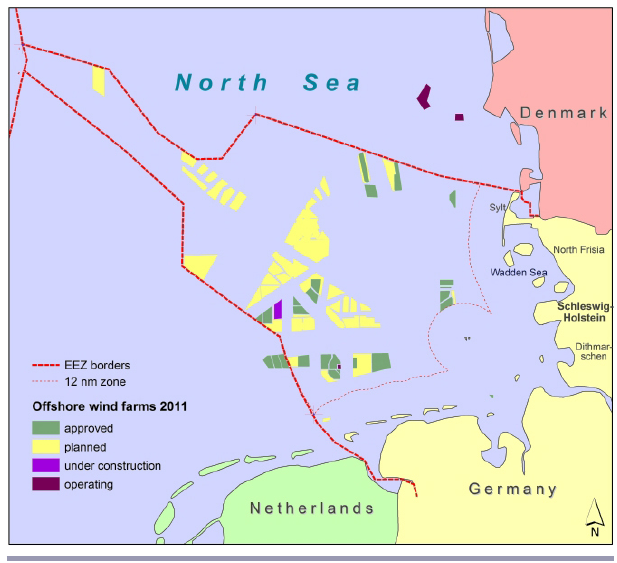
Fig. 1 . The case study area, comprising the administrative districts of North Frisia and Dithmarschen and the German Exclusive Economic Zone (EEZ; 12 nautical mile zone = German territorial sea). The map shows operating and possible future offshore wind farm developments in the southeastern North Sea (data sources: Zukunft Küste – Coastal Futures project data, German Federal Maritime and Hydrographic Agency [BSH], and the German Energy Agency